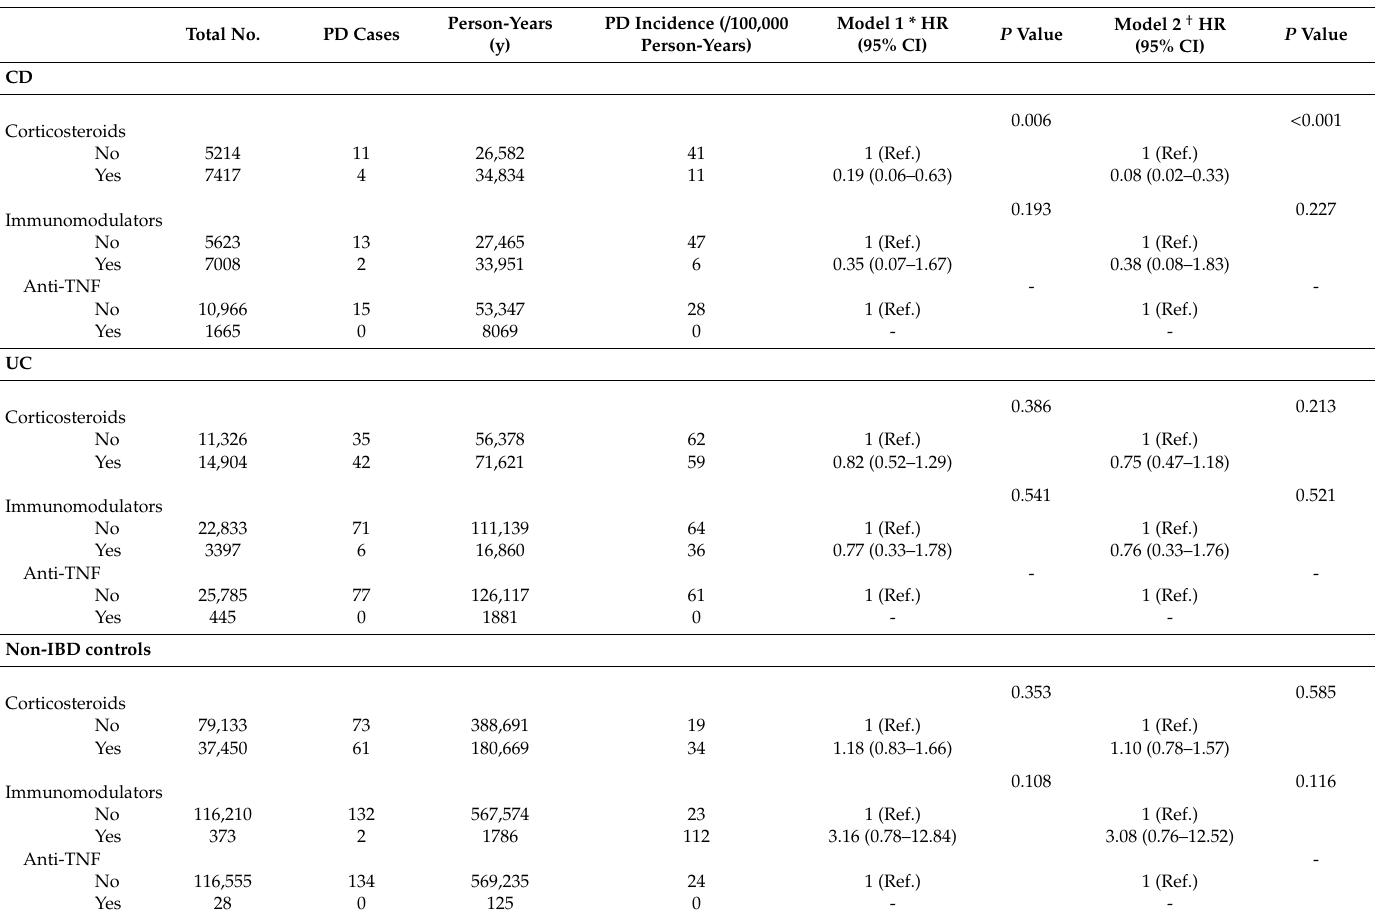
Table 3. Incidence and risk of Parkinson’s disease in patients with inflammatory bowel disease and non-inflammatory bowel disease controls according to medication. Total